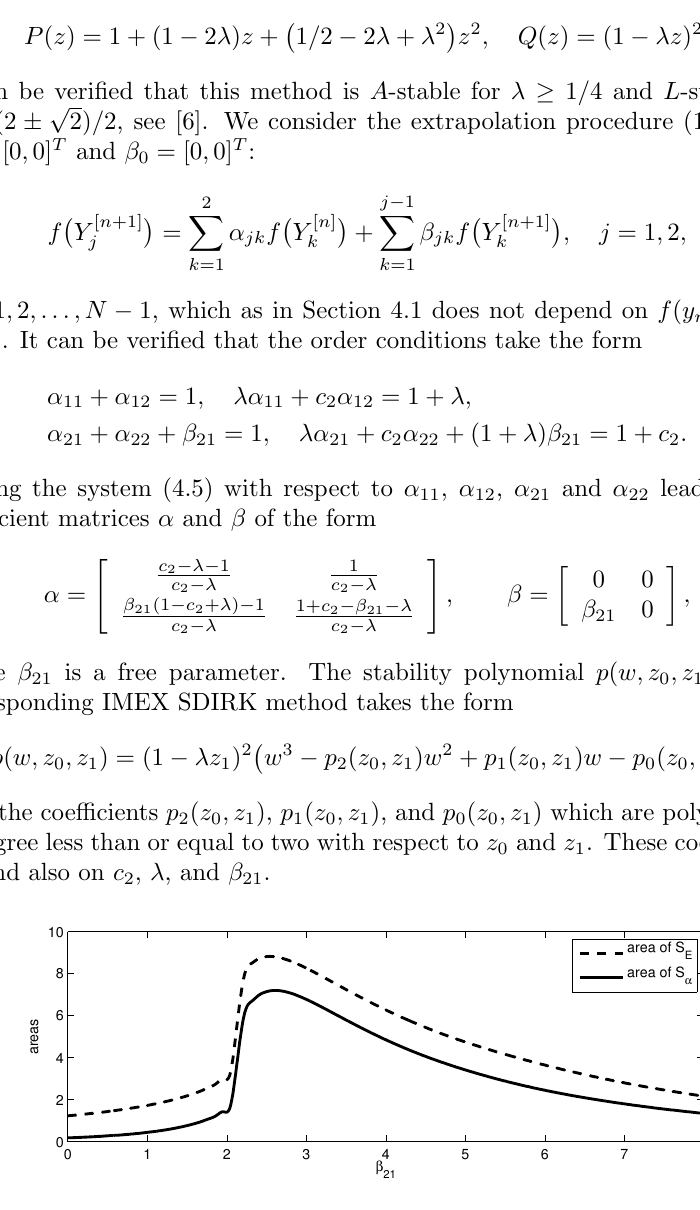
Figure 2. Areas of the stability regions S E = S E ( β 21 ) (dashed line) and S α = S α ( β 21 ) (solid line) for α = π/ 2, c 2 = 1, λ = (2 −